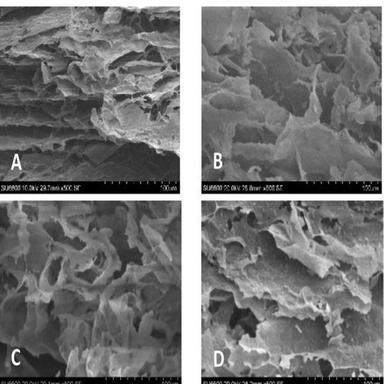
SEM micrographs – PR32.